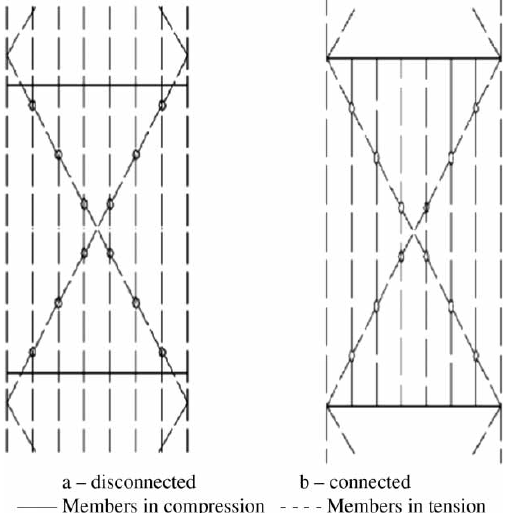
Fig. 10. Lateral load path in LSB systems (Stafford Smith,